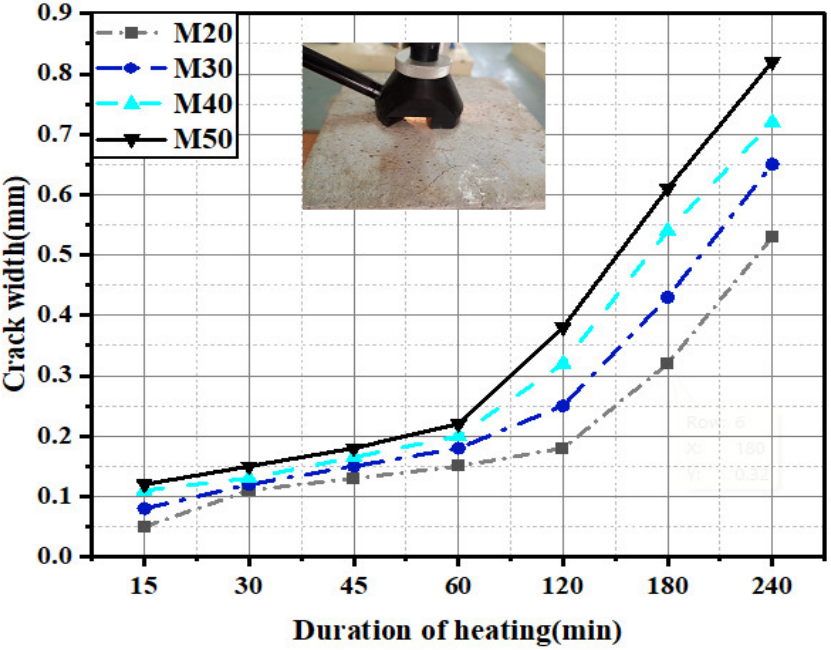
Figure 12. Microscopic view and range of crack widths in M-20 to M-50 concrete specimens after prolonged temperature exposure.